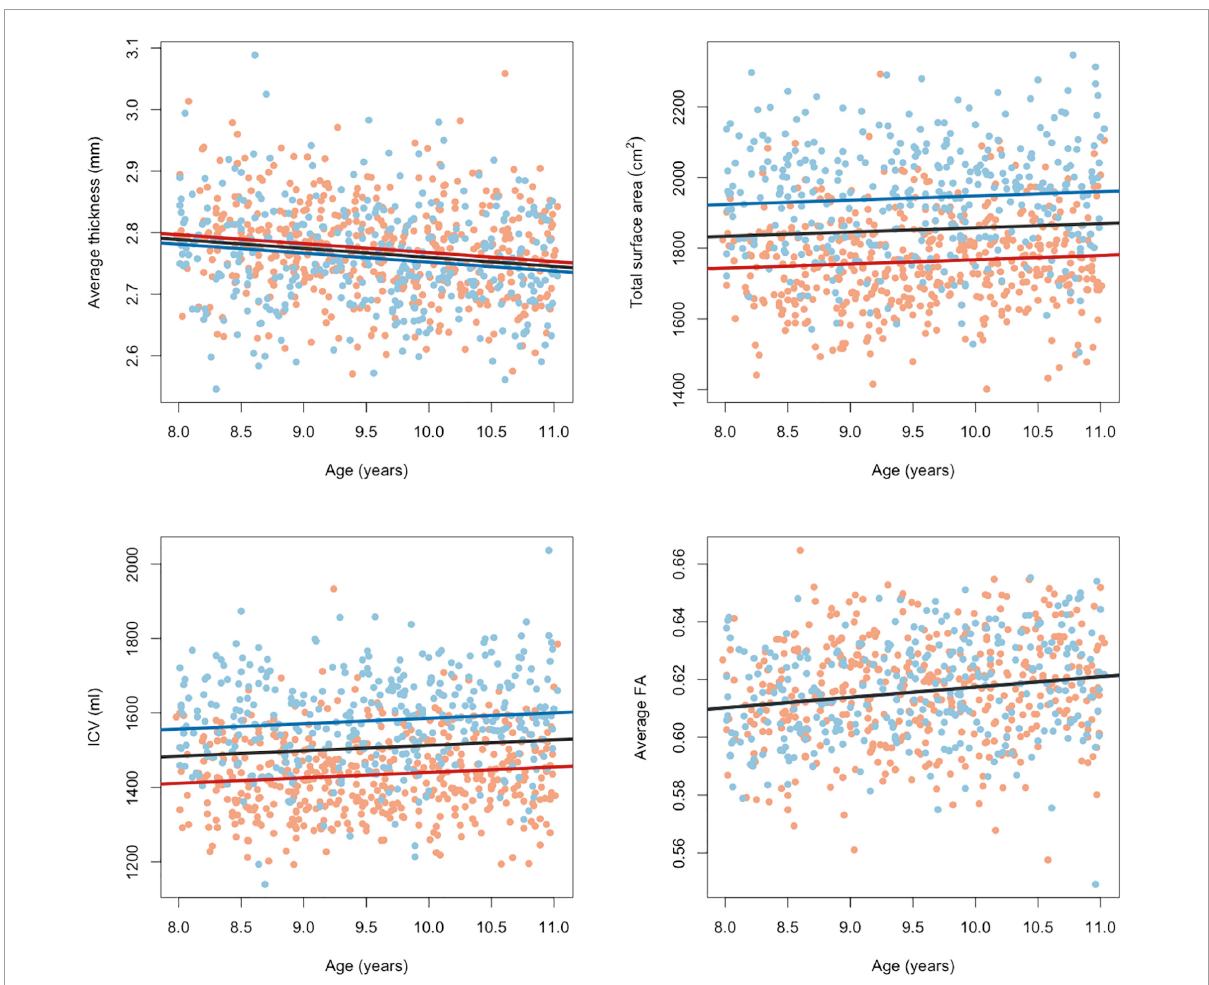
FIGURE3 Effects of age and sex on global brain measures. Red dots indicate brain measures in girls and blue dots indicate brain measures in boys. Lines show the relation modeled linearly between brain measures and age (for girls in red, boys in blue and in black for the group as whole). Fractional anisotropy measures were corrected for the different acquisition